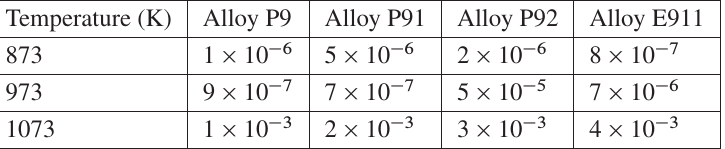
Table 4. Parabolic rate constants (Kp) of alloys O 2 + 50 % H 2 O (mg 2 mm (cid:3) 4 h (cid:3) 1 / .